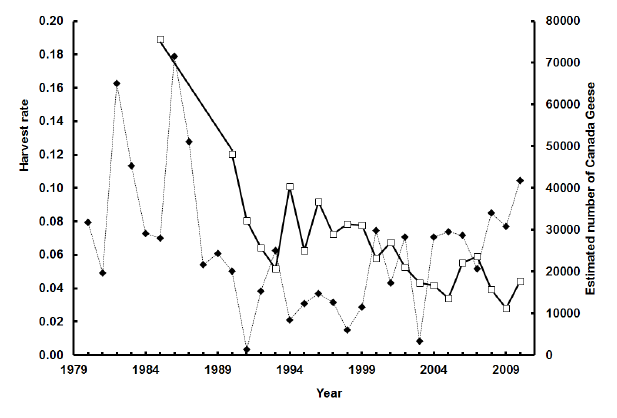
Fig. 1 . Harvest rates, i.e., banded birds shot and reported by hunters in the hunting season immediately following banding corrected for reporting rate, of Canada Geese banded as juveniles on Akimiski Island, Nunavut (closed diamonds, left Y-axis), and number of nesting (number of indicated breeding birds) and nonbreeding (geese counted in groups of > 3 birds) Canada Geese on Akimiski Island, Nunavut, from 1985-2010, based on aerial surveys (see Leafloor et al. 1996 for details; open squares, right